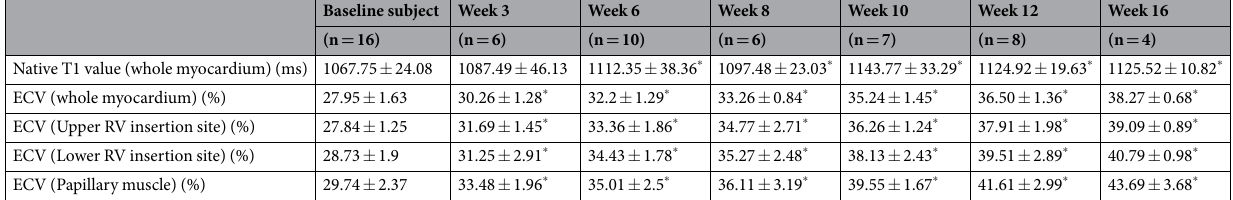
Table 2. Cardiac magnetic resonance (CMR) data of all subjects.